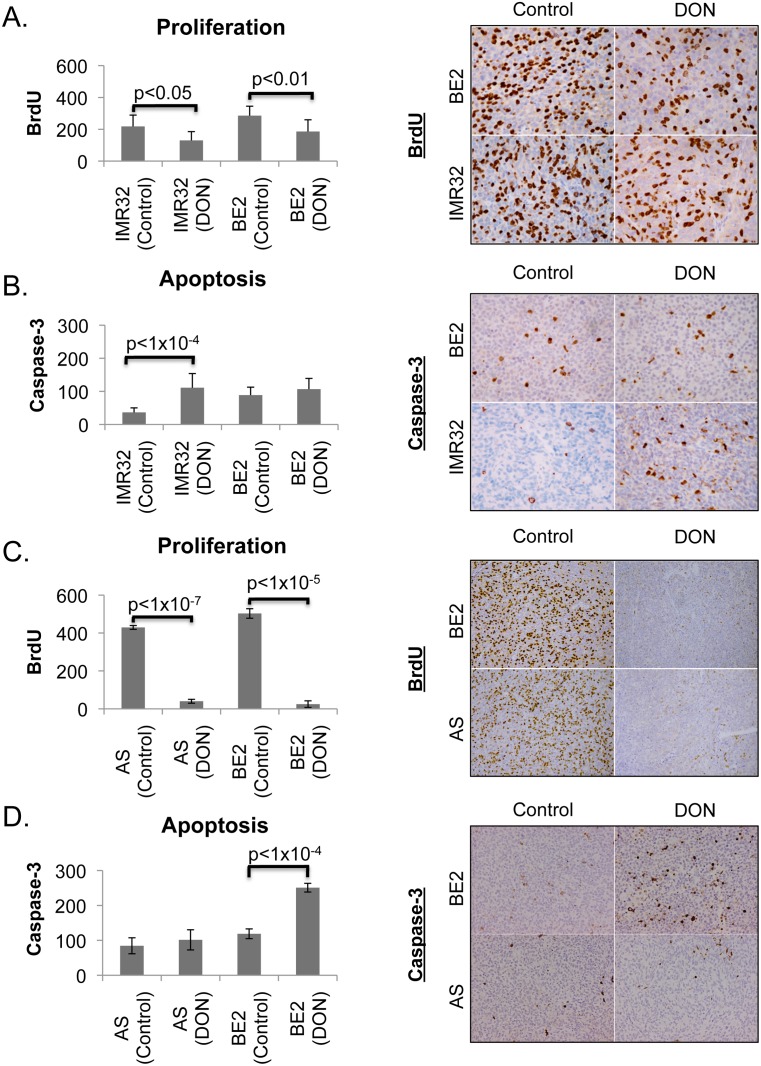
DON causes increased apoptosis in high-Myc, but not low-Myc expressing NBL tumors.(A and B) Immunohistochemistry (right panel) and quantification (left panel) of BrdU and cleaved Caspase-3 positive cells, respectively, in subcutaneous IMR32 and SK-N-BE2 tumors treated with 50mg/kg DON, twice weekly. (C and D) Immunohistochemistry (right) and quantification (left) of BrdU and cleaved Caspase-3 positive cells for both SK-N-AS and SK-N-BE2 tumors treated with 100mg/kg DON, twice weekly. Significance was determined by Student’s t test.